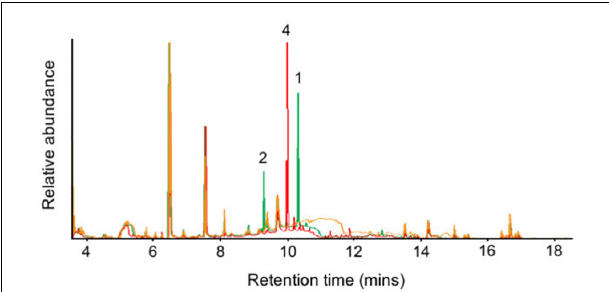
FIGURE 5 | GC-MS chromatograms of the extracts from the Sts1 and Sts2 heterologous expression in yeast. Overlapped chromatograms of extracts from yeast harbouring Sts1 (red), Sts2 (green) and an empty vector (orange). The presence of 1, 2, and 4 is indicated.